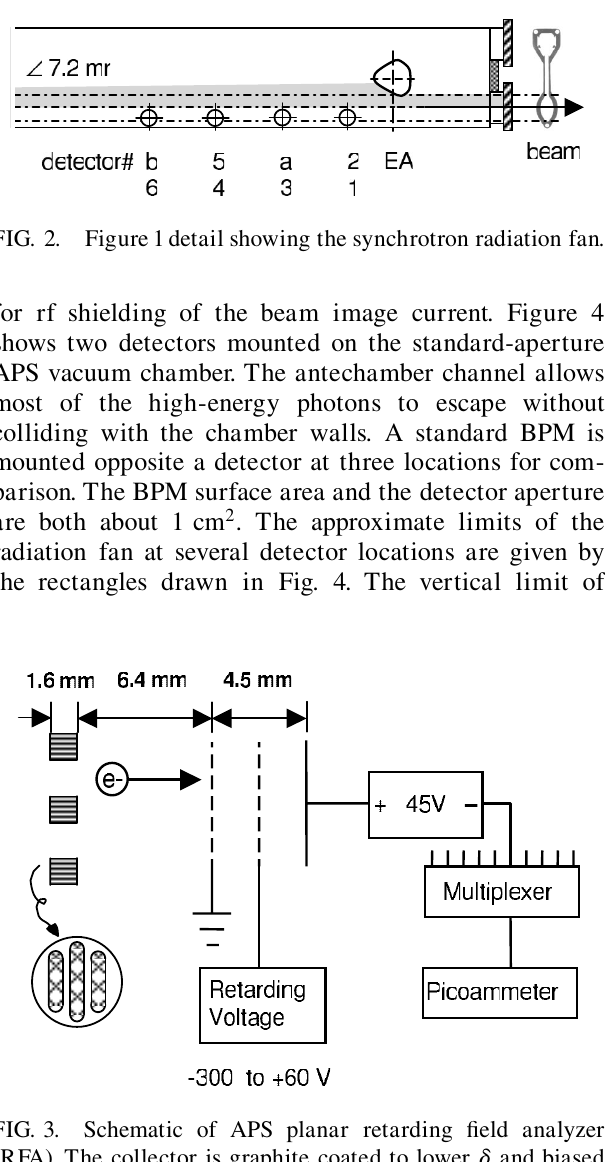
FIG. 4. Cross-sectional schematic view of the vacuum cham- ber showing mounted RFA detectors. The measured transmis- sion through the two grids is (cid:7) 80% . The synchrotron radiation fan cross sections for photons with energies > 4 eV are shown schematically at selected detector locations. At detectors 3, 6, and 9, a standard BPM is mounted on top. The chamber dimensions, half width (cid:8) half height, are ( 42 : 5 (cid:8) 21 )